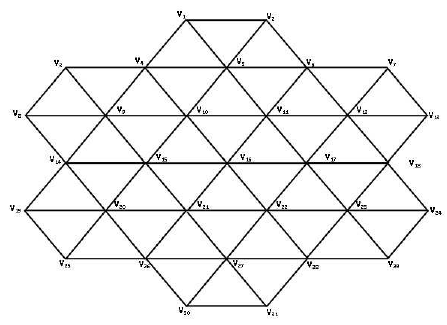
Fig. 3 Model of Healthy